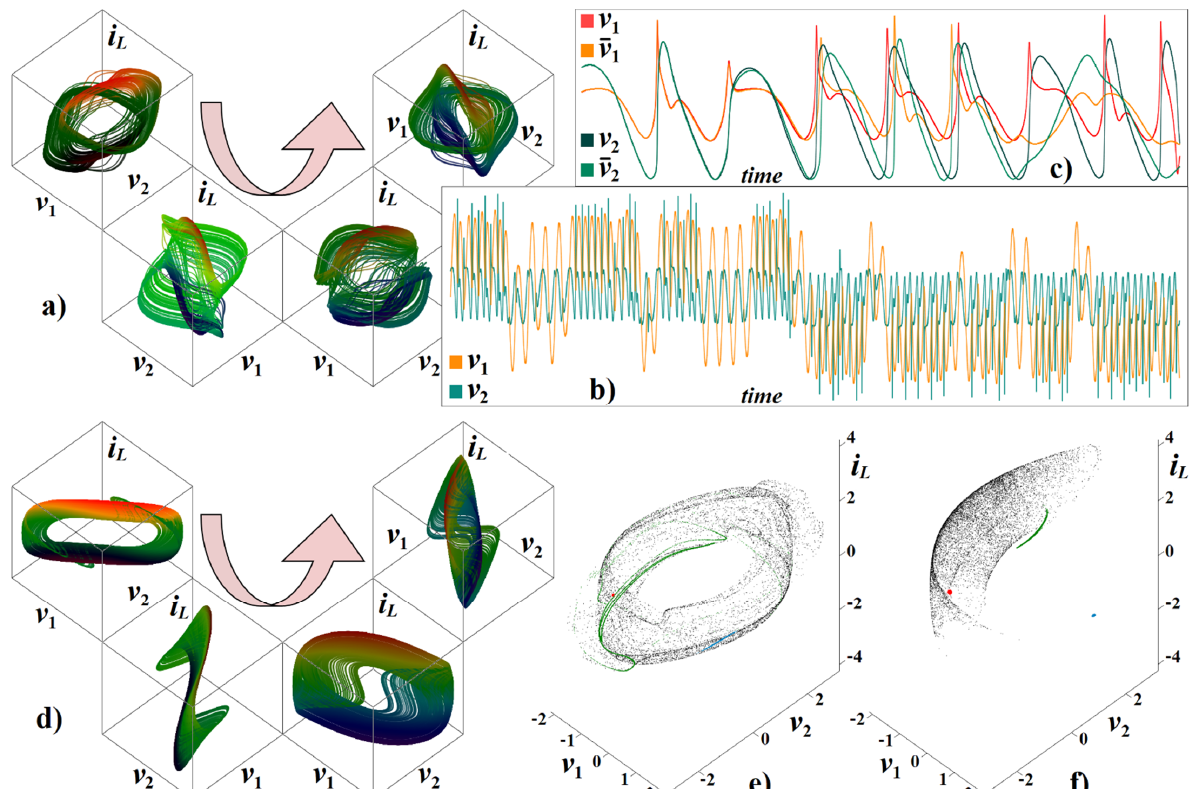
Figure 3. Numerical analysis of third order dynamical system: ( a ) 3D plot of the typical strange attractor generated by (1) with parameter set (7), ( b ) chaotic waveforms in time domain, ( c ) sensitivity of system solution to small changes of the initial conditions plotted with respect to time, ( d ) 3D plot of the typical strange attractor generated by (1) with parameter group (8), ( e , f ) sensitivity of system solution visualized in the state space, see text for details. Ranges for individual state variables in plot ( a ) are v 1 ∈ ( − 4, 4) V, v 2 ∈ ( − 2, 2) V, and i L ∈ ( − 2, 2) A, axis ranges for plot ( d ) are v 1 ∈ ( − 1, 1) V, v 2 ∈ ( − 2, 2) V, and i L ∈ ( − 2, 2)